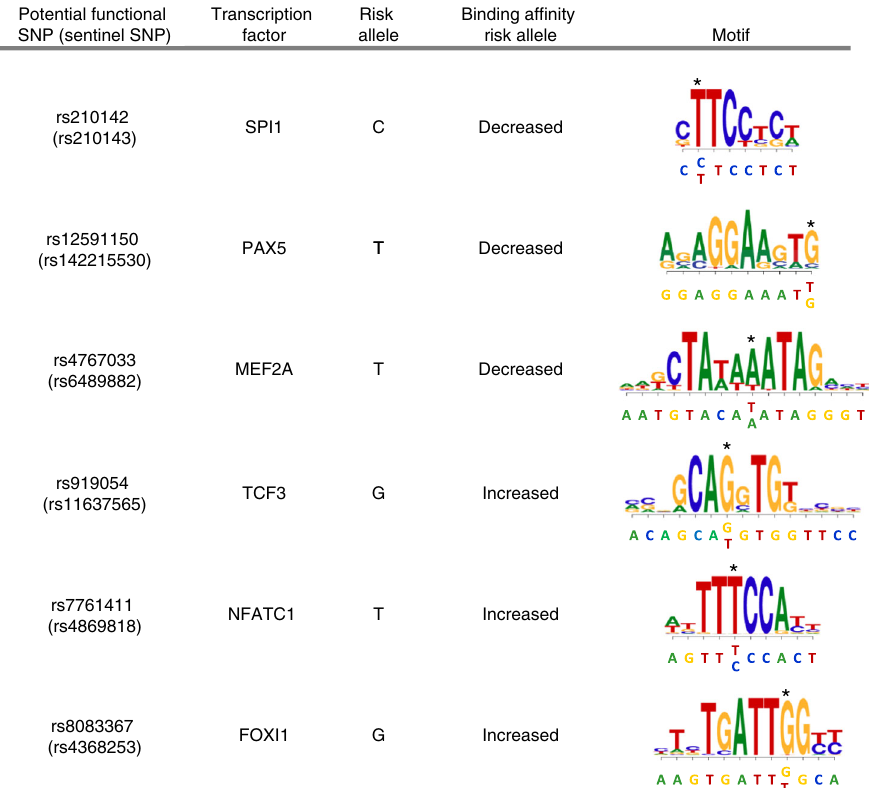
Fig. 3 Transcription factor (TF)-binding motif analysis. Examples of altered TF-binding motifs at potential functional risk loci. The affected nucleotides in the different motifs are marked by an asterisk. The sequence surrounding the single-nucleotide polymorphism (SNP) is located under the motif graphs, with the different possible alleles of the potential functional SNP indicated below each